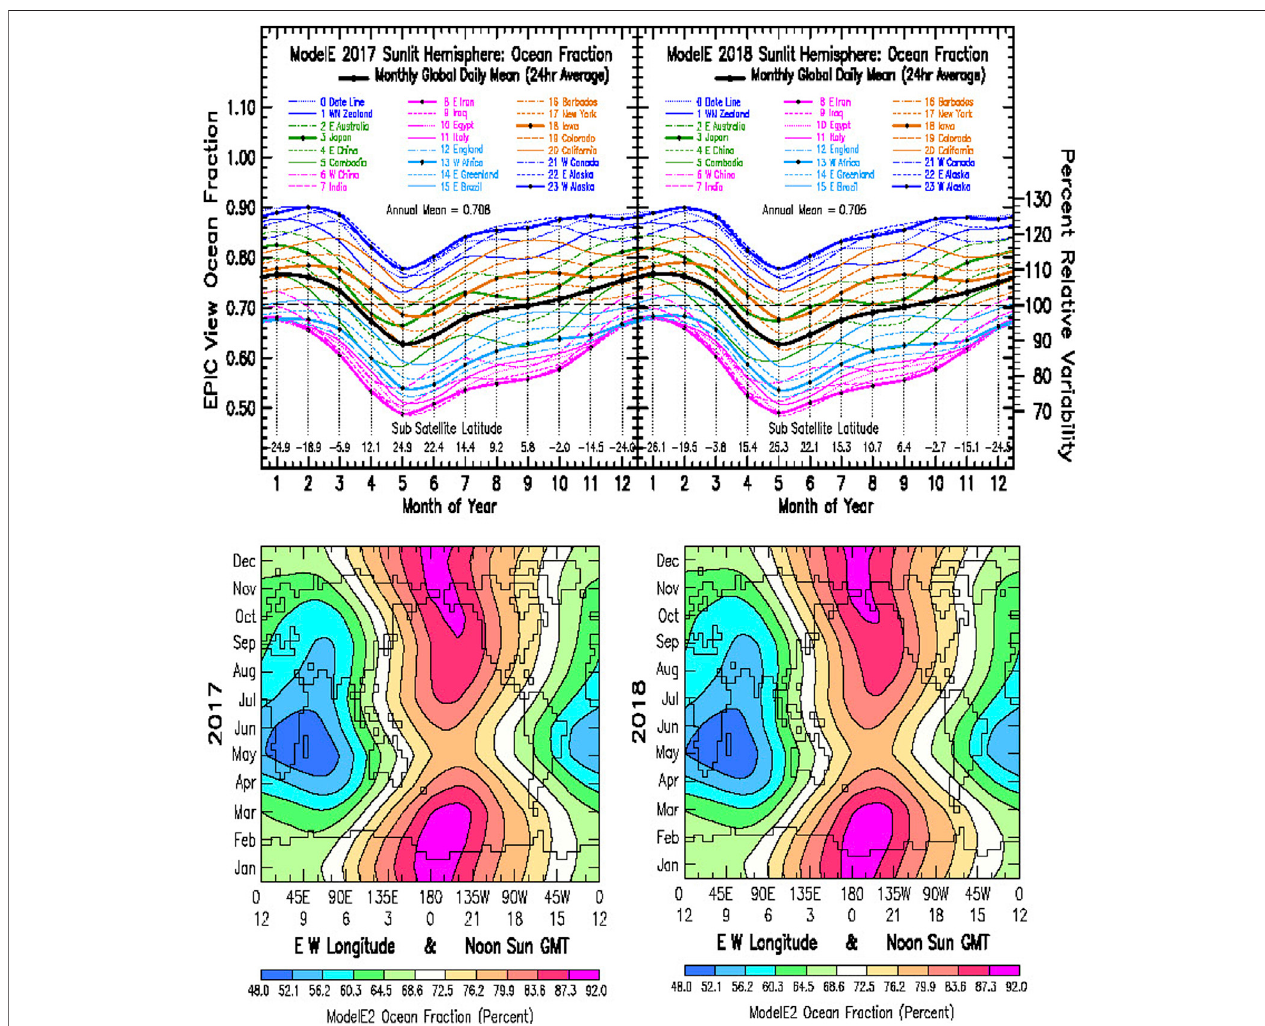
FIGURE 15 | Upper Left : Line plot of the ModelE2 ocean fraction for the year 2017. Upper Right : Line plot of the ModelE2 ocean fraction for the year 2018. Lower Left : Hovmöller contour map of the ModelE2 ocean fraction for year 2017. Lower Right : Hovmöller contour map of the ModelE2 ocean fraction for year 2017. The seasonal change in ocean fraction is due to the DSCOVR Spacecraft Lissajous orbital motion as denoted by the Sub-Satellite latitude at fi gure bottom. The tiny differences in the line and Hovmöller plots between years 2017 and 2018 arise from the slow orbital drift of the DSCOVR Spacecraft in its Lissajous orbit.